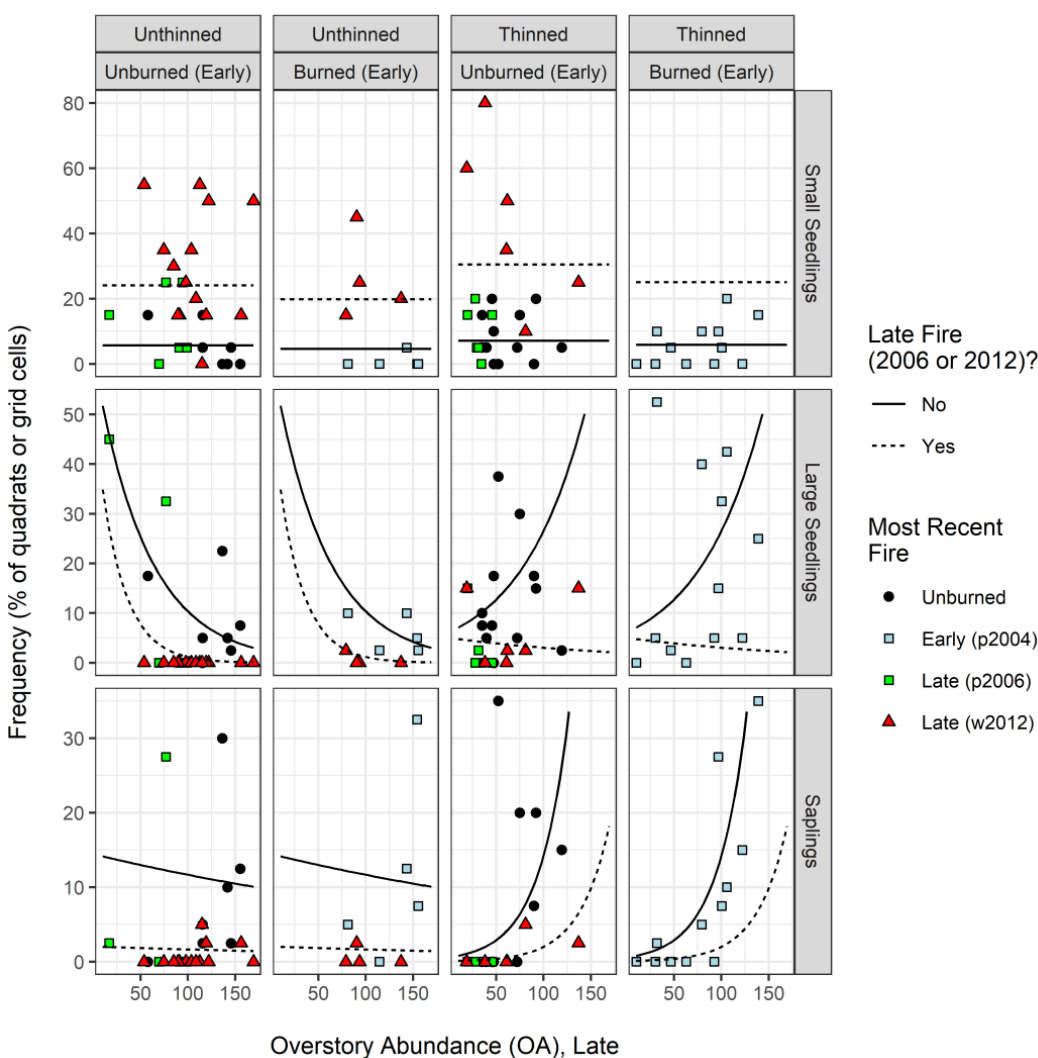
Figure 9. Frequency of small seedlings ( < 0.3 m tall), large seedlings (0.3–1.37 m tall), and saplings ( > 1.37 m tall, < 7.6 cm DBH) in the Late (2015) sample. Values are the percentage of 20 quadrats per plot (small seedlings) or percentage 40 grid cells per plot (large seedlings and saplings). For each interval, plot values of OA represent the start of the interval. See Figure 3 for other details and Table 2 for statistical results. Note the differences in scale of the vertical axes.